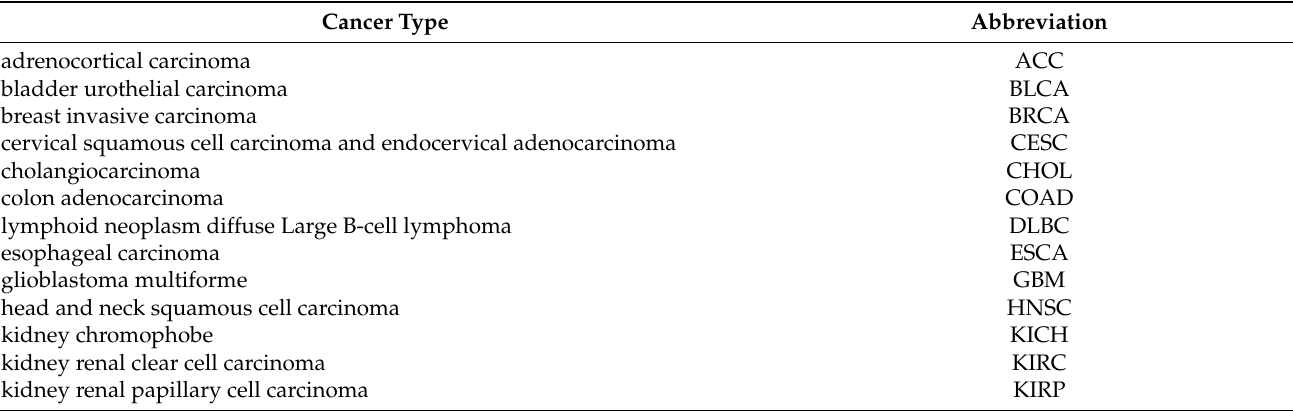
Table 1. The abbreviations and corresponding full names of 33